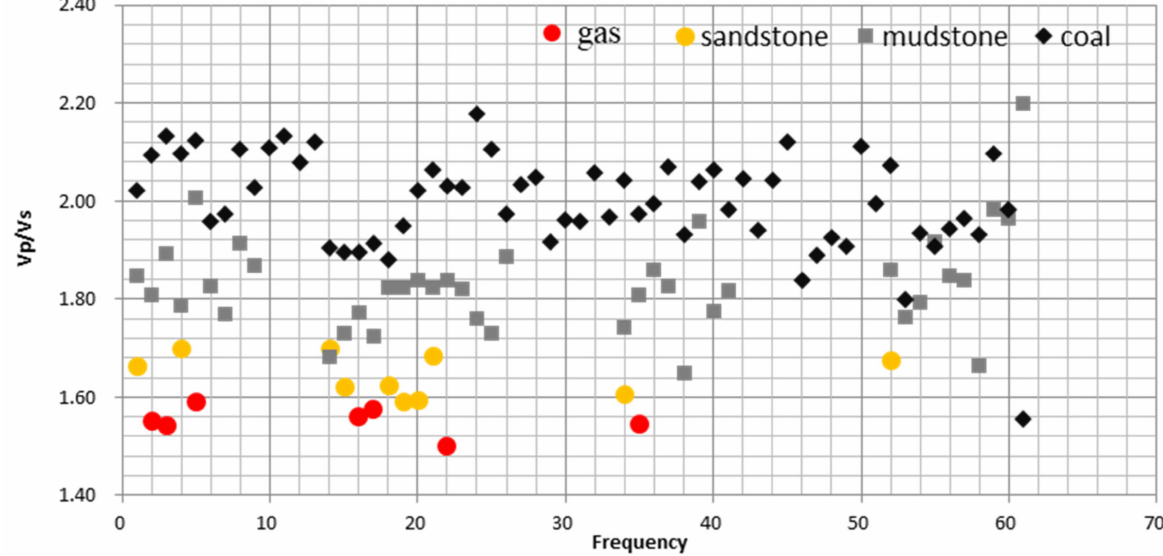
Figure 4. Distribution characteristics of the velocity ratios of compressional and shearing waves for different